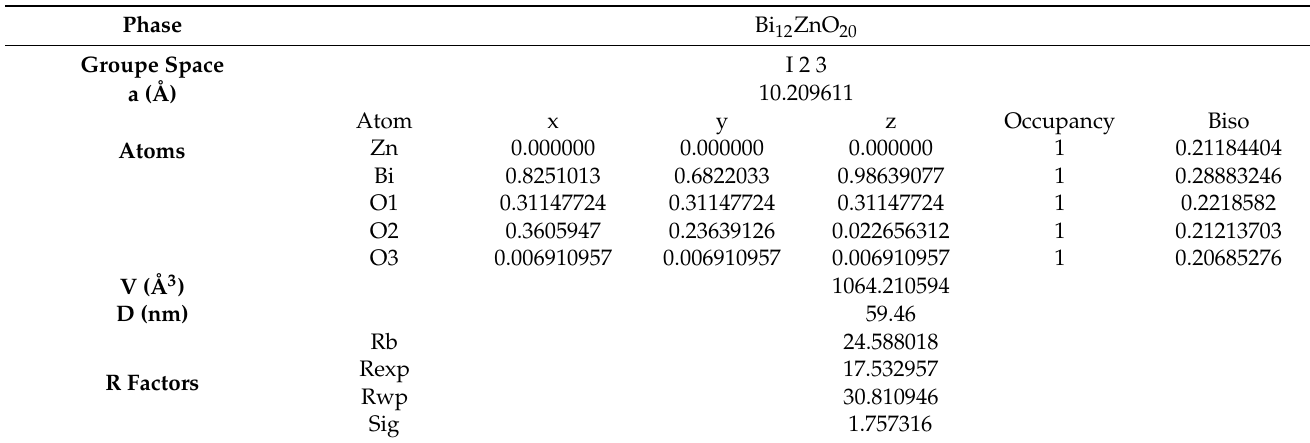
Figure 2. Rietveld refined XRD pattern for the Bi 12 ZnO 20 nanoparticles. The circles represent experimental points and the red line represents Rietveld refined data. Inset: supercell model for bulk Bi 12 ZnO 20 . Table 1. Structural and lattice parameters.